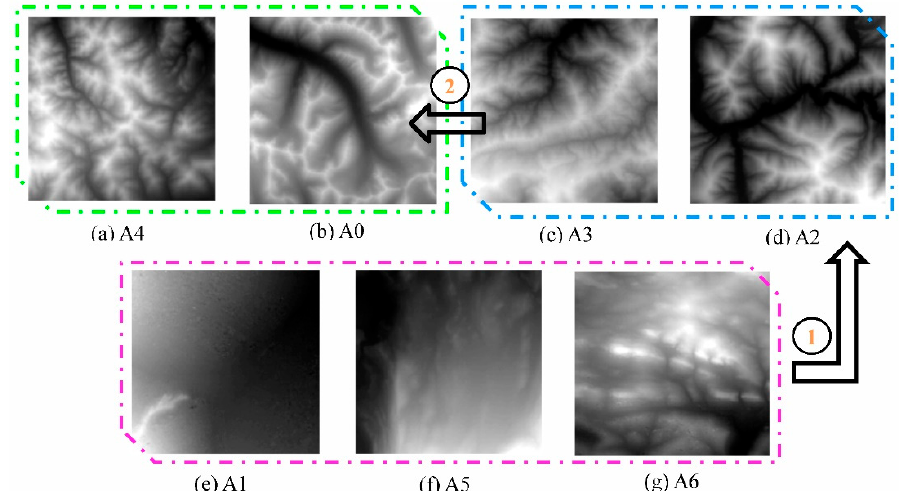
Figure 4. Texture mapping of landform in DEM images. ( a ) A4: Low relief extremely high moun- tain; ( b ) A0: High relief extremely high altitude mountain; ( c ) A3: Intermediate relief middle mountain; ( d ) A2: Intermediate relief high mountain; ( e ) A1: High altitude plain; ( f ) A5: Extremely high altitude plain; ( g ) A6: Extremely high altitude high-hill.